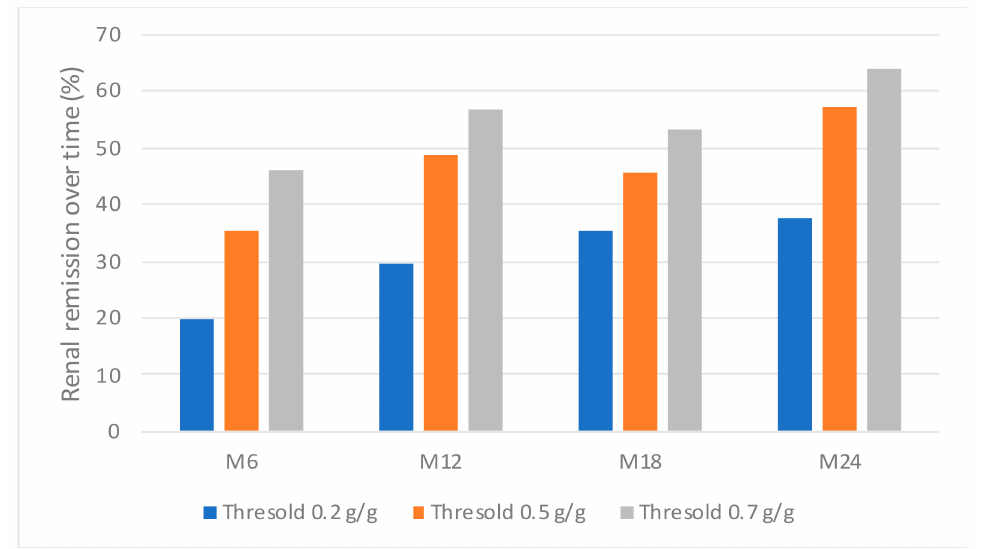
Figure 2. Renal remission over time according to three different thresholds for